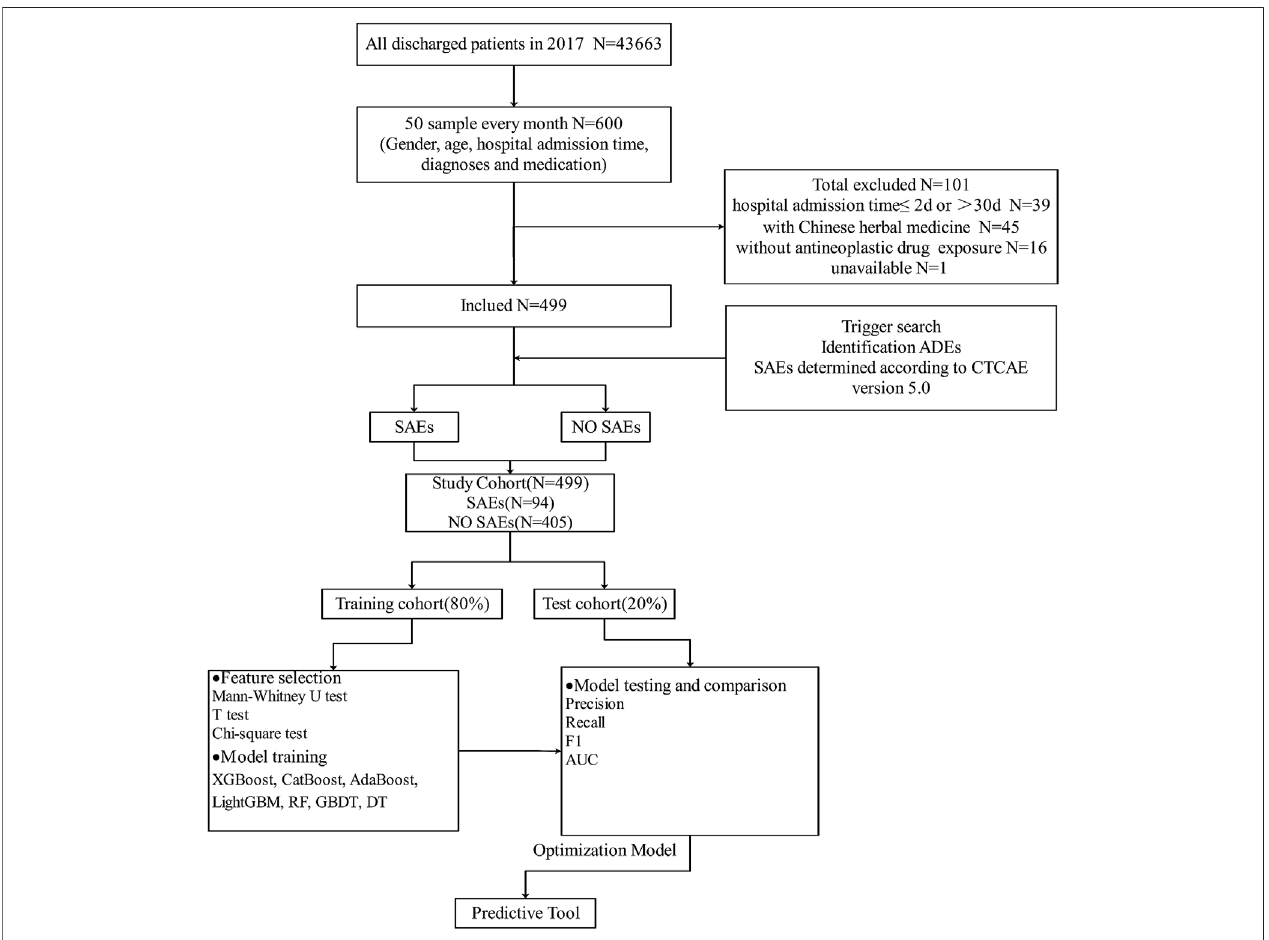
FIGURE 1 | Overview of the study design and model